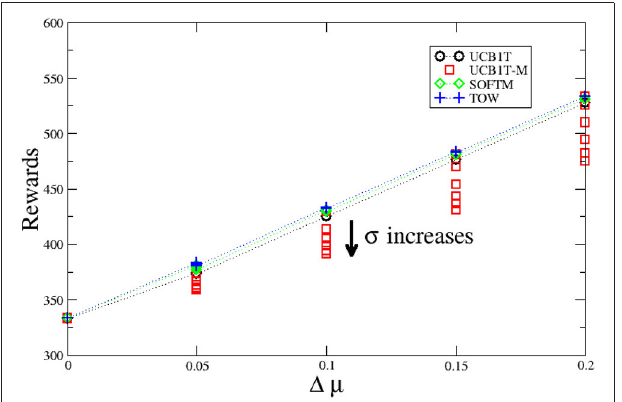
FIGURE 1 | Performance comparison between four learning algorithms for MAB where PDFs are δ ( 1 3 ) and N ( 1 3 + 1 µ , σ 2 ). 1 µ is positive (cases where machine B is correct decision).